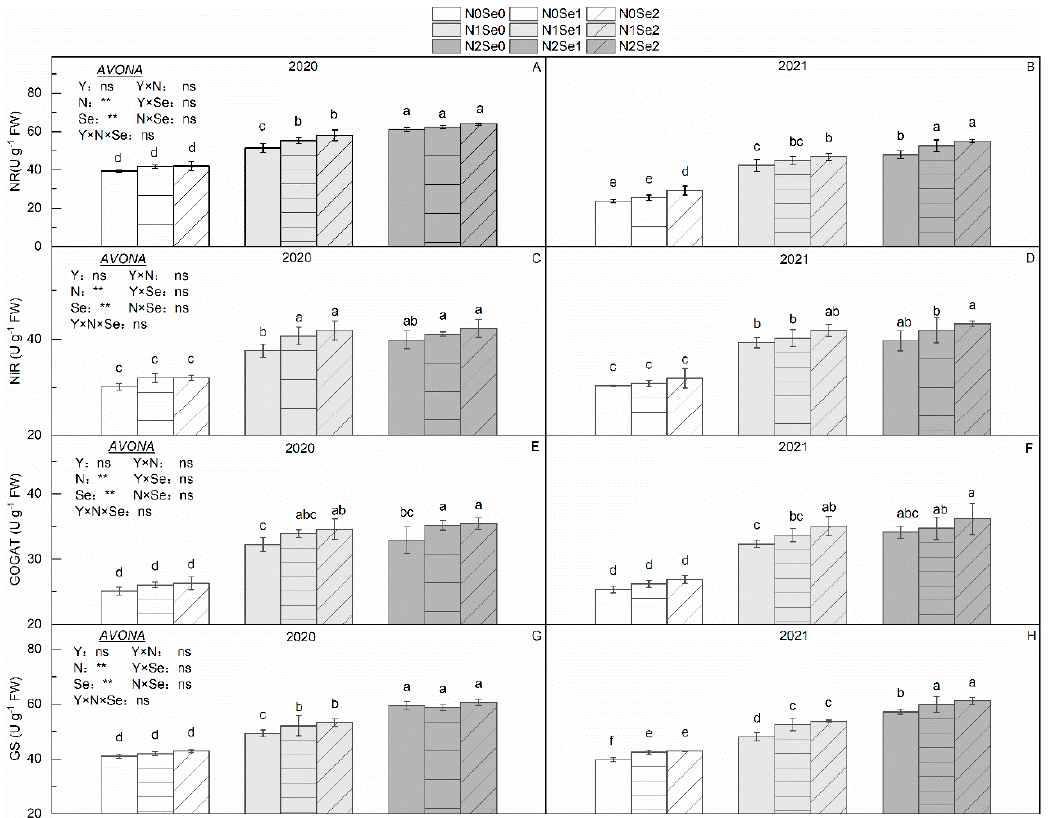
Figure 1. Effects of selenium and N fertilizers on the activity of N-metabolizing enzymes in wheat. Y = Years, N = Nitrogen, Se = Selenium. ( A , C , E , G ) represent NR activity, NiR activity, NADH-GOGAT, GS in 2020, respectively. ( B , D , F , H ) represent NR activity, NiR activity, NADH-GOGAT, GS in 2021, respectively. N0, N1 and N2 indicate 0 kg N ha − 1 , 180 kg N ha − 1 and 270 kg N ha − 1 , Se0, Se1 and Se2 indicate 0 g Se ha − 1 , 450 g Se ha − 1 and 900 g Se ha − 1 . Different lowercase letters indicate statistical differences among the treatments at p < 0.05. “ns” means no significant difference ( p > 0.05). * and ** represent the significance levels of p < 0.05 and p < 0.01, respectively.